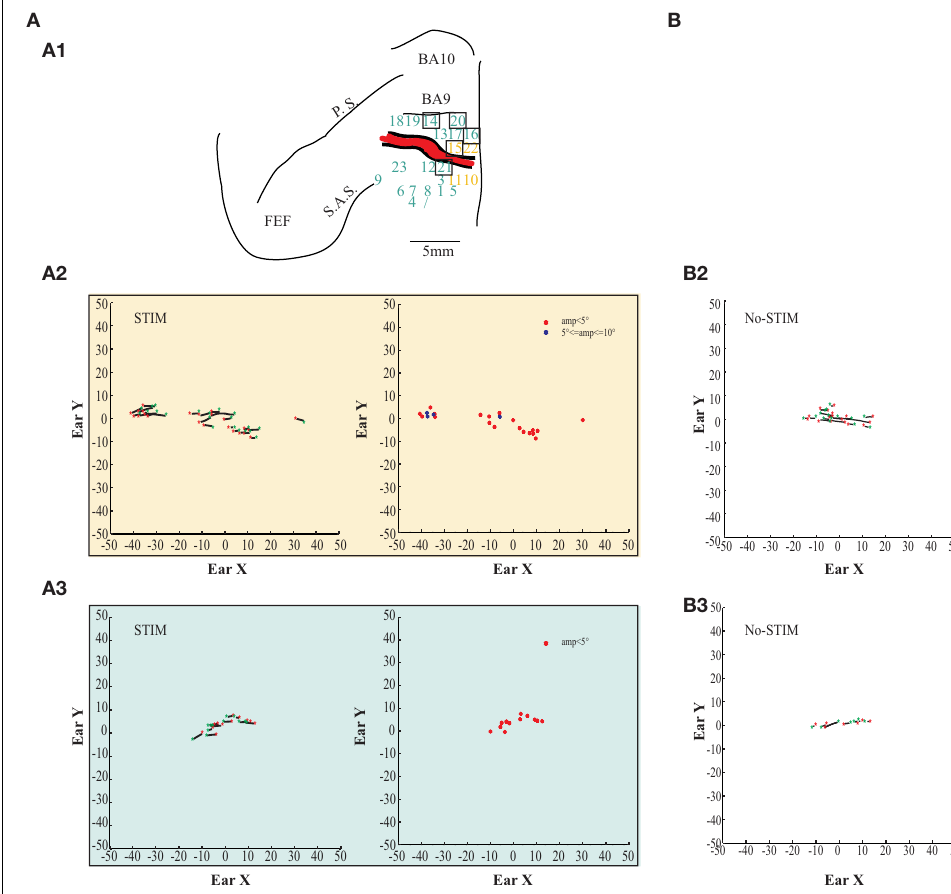
shows the relationship between starting position and movement amplitude. (A3) Example of fixed-vector backward ear movements in the belt region. (B) The figures show self-generated ear movements. (B2) The plots show self-generated ear movements sampled outside the stimulation period and from the same experimental session of panel (A2) . The plot on the left shows the direction of the ear movements. The plot on the right shows the relationship between starting position and movement amplitude. (B3) The plots show self-generated ear movements sampled outside the stimulation period and from the same experimental session of panel (A3) . The plot on the left shows the direction of the ear movements. The plot on the right shows the relationship between starting position and movement